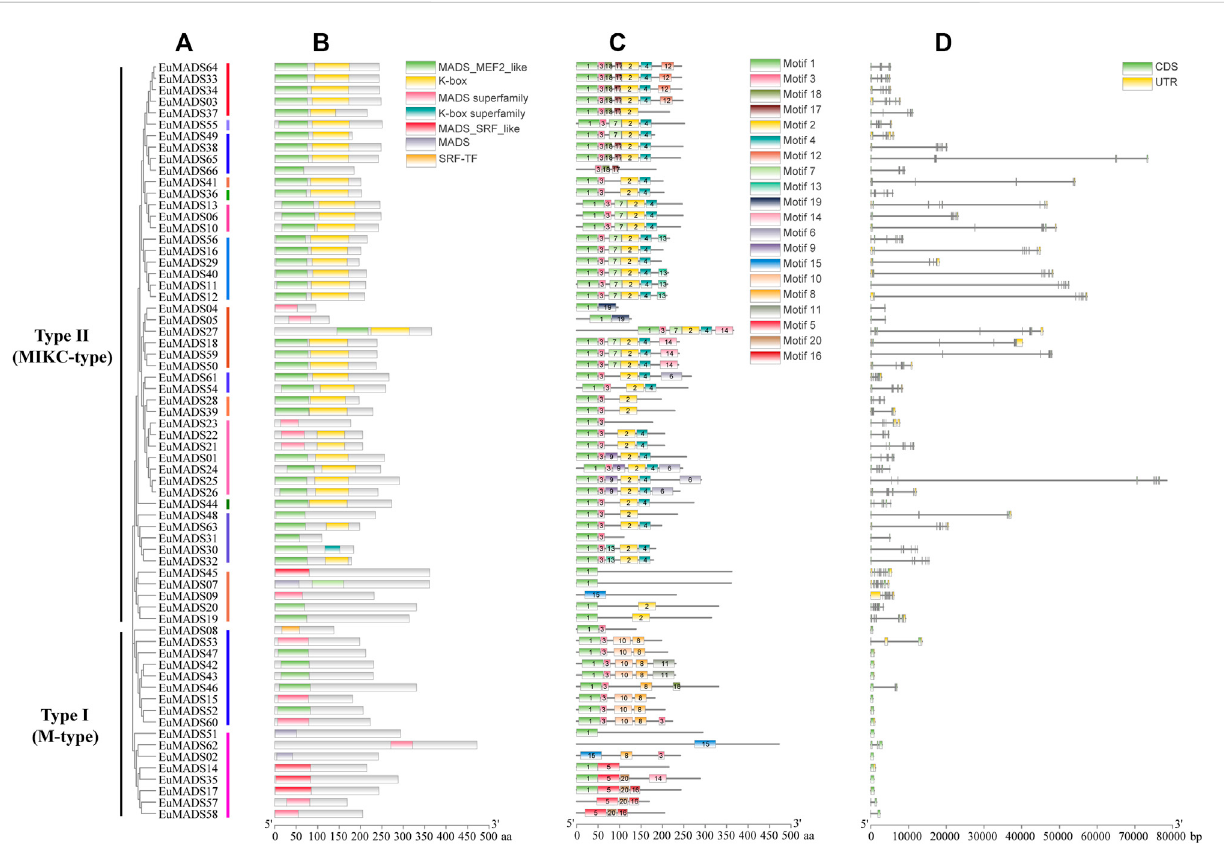
FIGURE 5 Proteindomain,motifandgenestructureofEuMADStranscriptionfactors. (A) Phylogeneticrelationshipofthe EuMADS genefamily.TypeI(M-type) including 2 clades and Type II (MIKC) including 14 clades are indicated by colored vertical lines. (B) Conserved protein domains of EuMADS transcription factors. (C) Protein motif composition of EuMADS transcription factors. The seven domains and 20 motifs are boxed in different colors, respectively. (D) Exon-intron structure of EuMADS genes. CDS, UTR and intron are represented by green, yellow boxes and black lines,